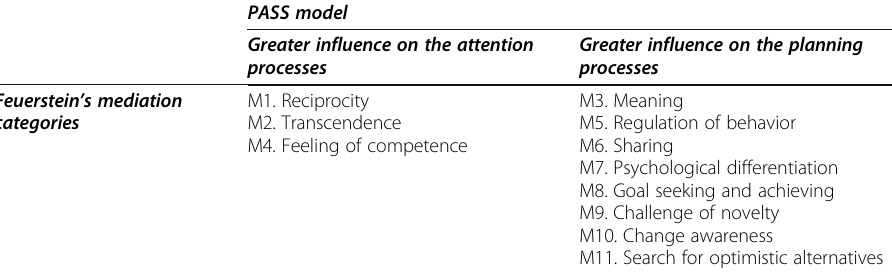
PASS model Greater influence on the attention processes